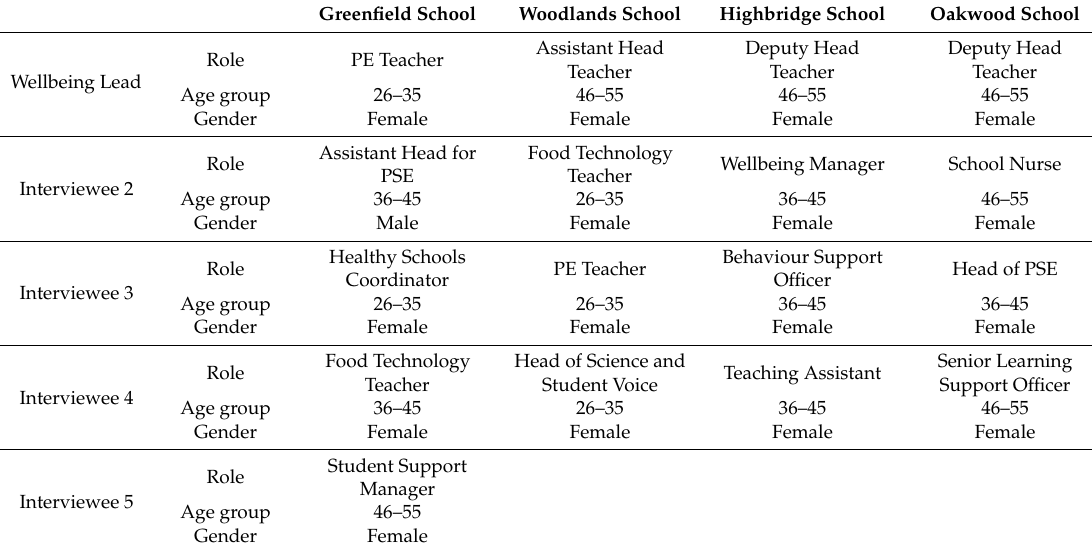
Table 3. Characteristics of school sta ff